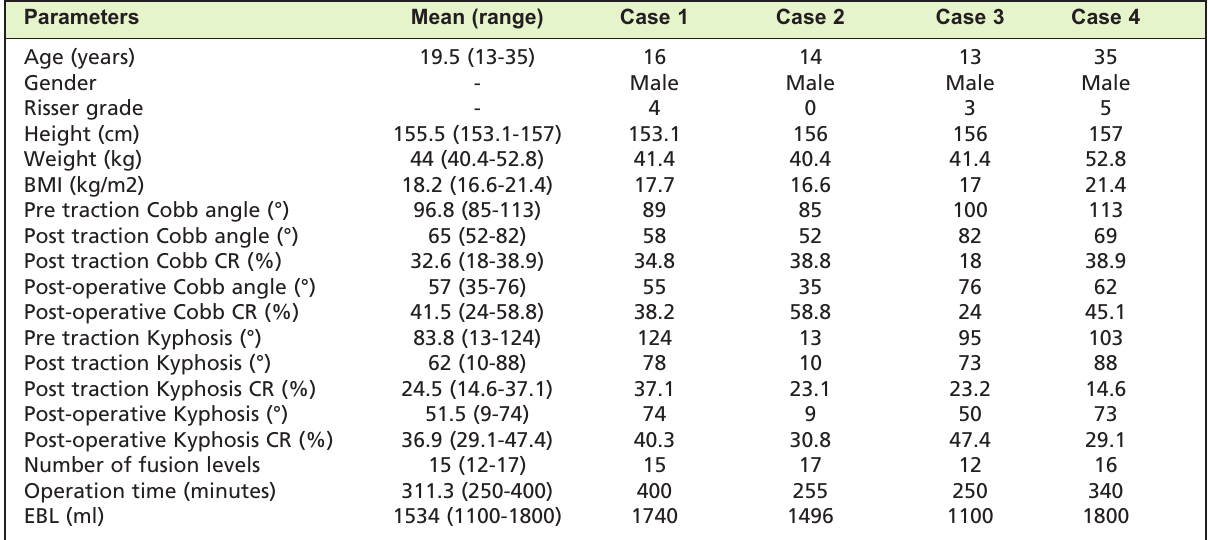
Demographic and perioperative data Table I: